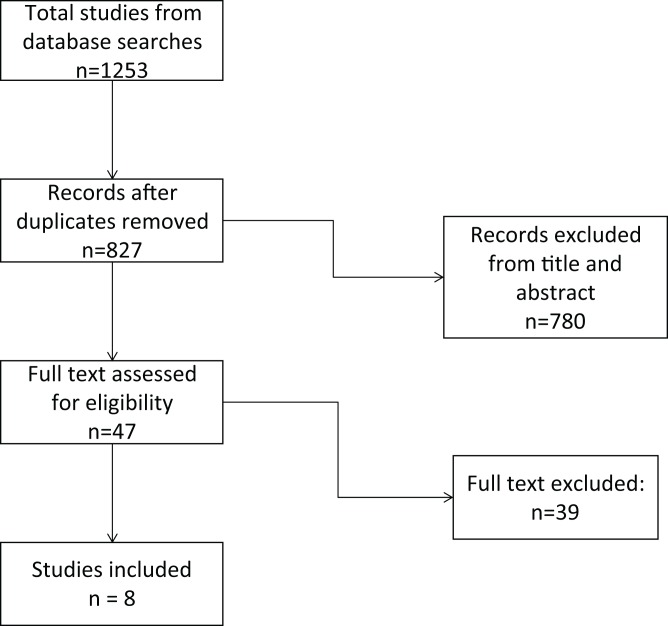
PRISMA flow diagram.